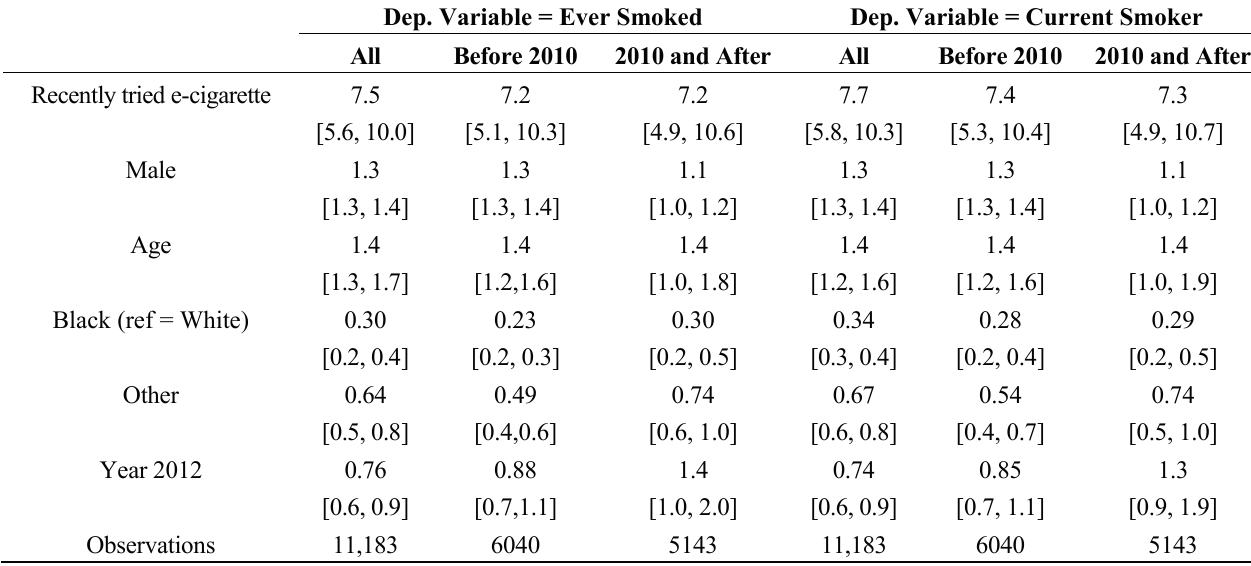
Table 9. Association of smoking and e-cigarette recent trying, by time of first trying a cigarette: before 2010 vs. later (ORs and 95% CIs).